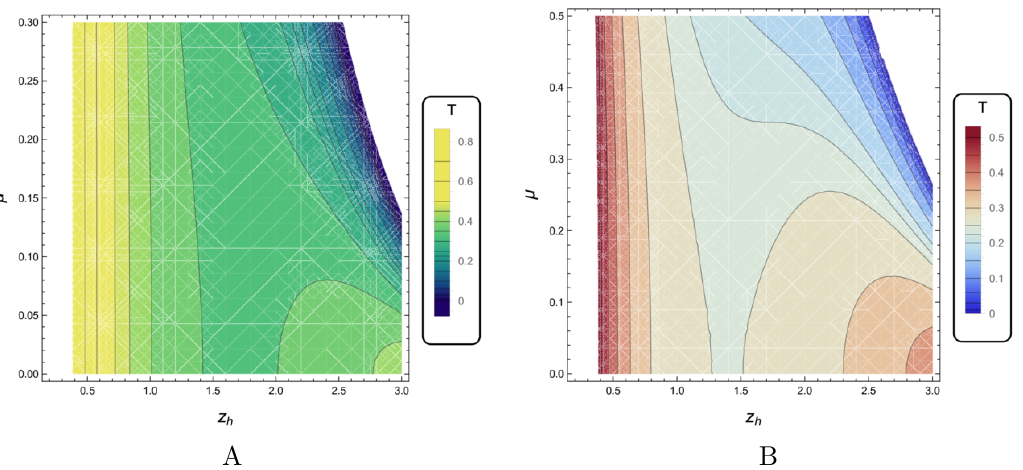
Figure 21 . Contour lines of the temperature T = T ( z h ; (cid:22); c; (cid:23) ) for c = (cid:0) 1 in the isotropic (A) and anisotropic (cid:23) = 4 : 5 (B) cases.